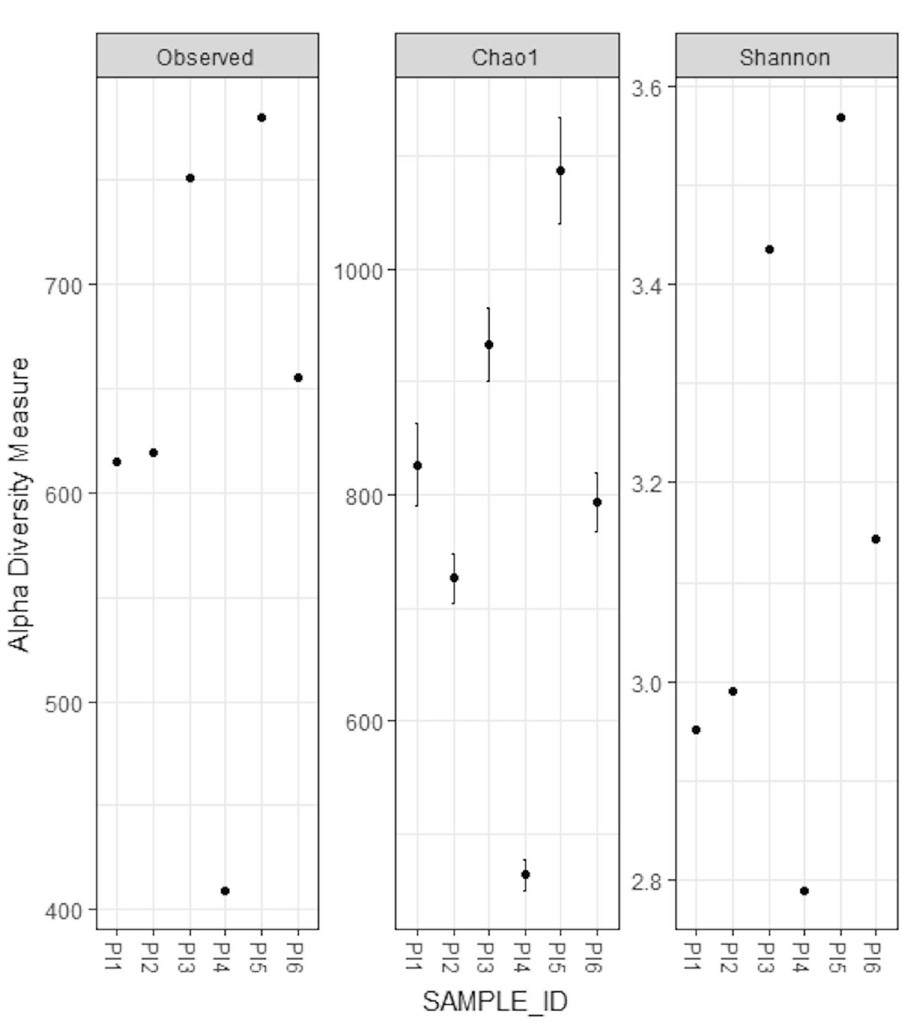
Figure 6. Alpha diversity by sample. The number of observed OTUs has been plotted for each sample, Chao1 and Shannon entropy diversity indices are reported. The bars are the standard errors as defined for the Chao1 model for estimating